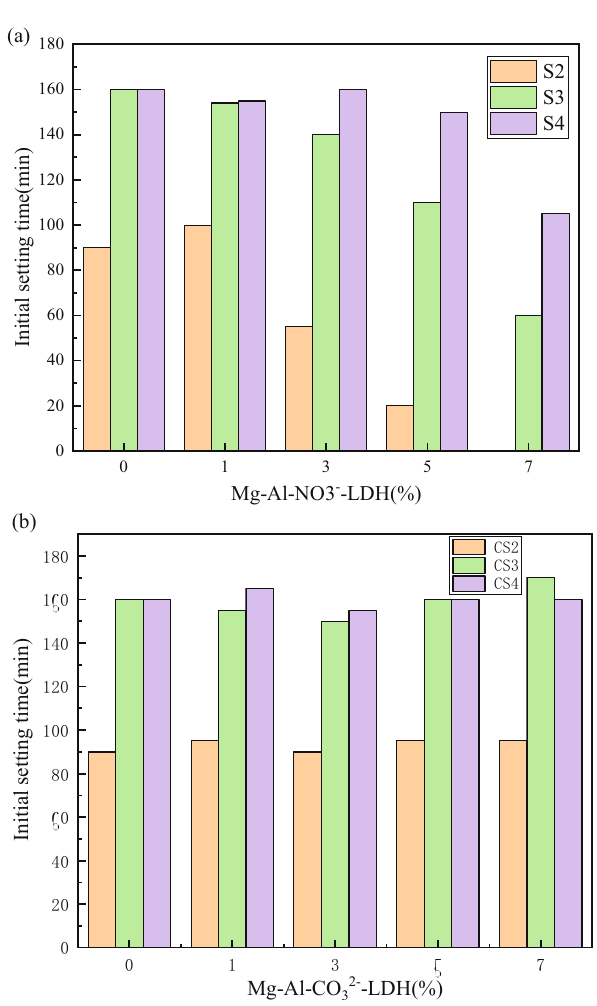
Figure 4: Initial setting time of cement paste: ( a ) Mg – Al – NO 3− - LDH and ( b ) Mg−Αl−CO LDH 32− -